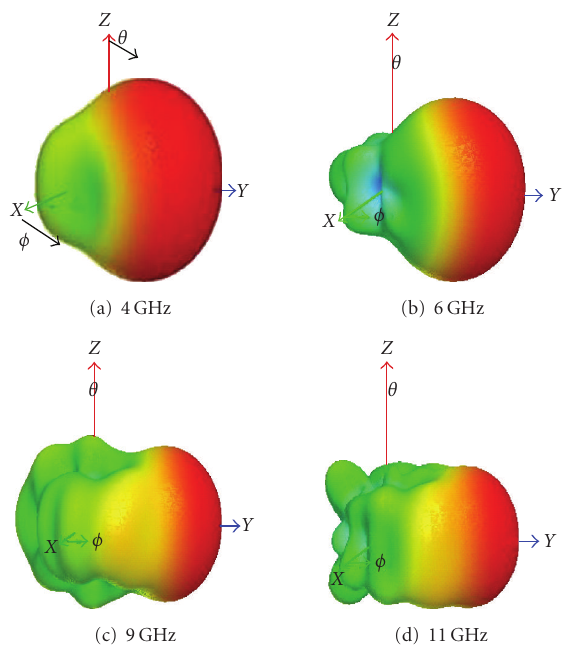
Figure 5: The simulated three-dimensional radiation pattern.